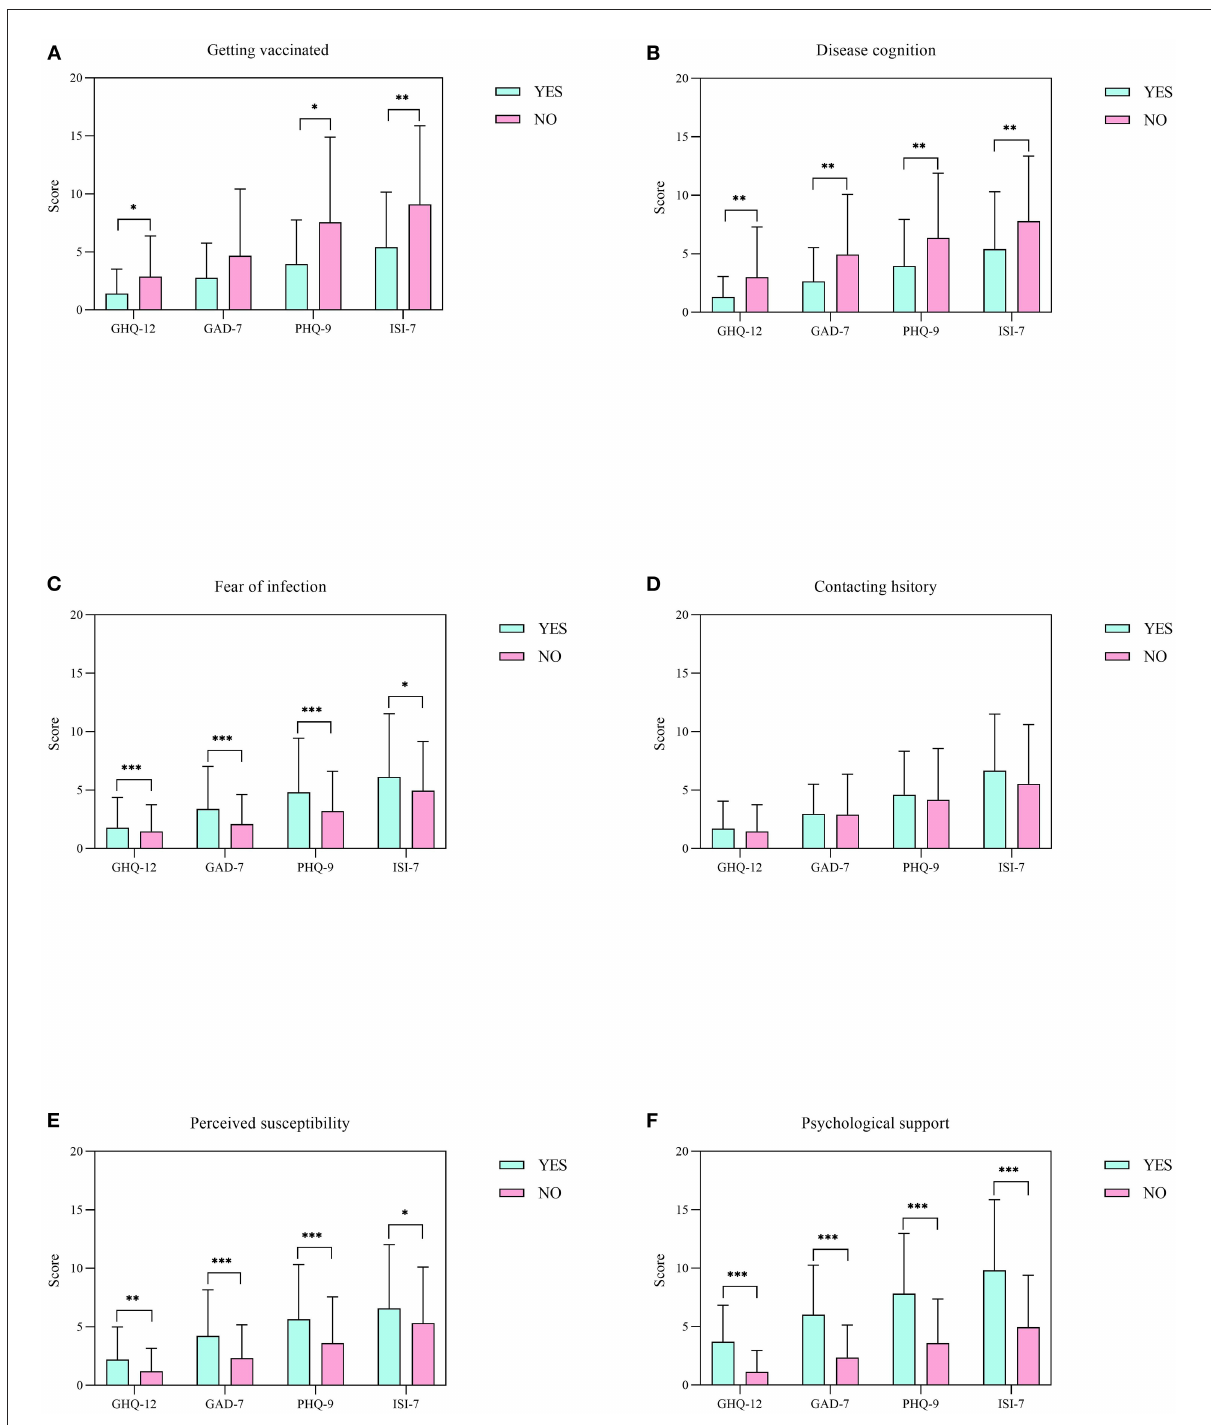
FIGURE2 Comparison of the responses of HCWs for COVID-19-related surveys. (A–F) Scores on the GHQ-12, GAD-7, PHQ-9 and ISI-7 scales for getting vaccinated, disease cognition, fear of infection, contacting history, perceived susceptibility and psychological support among healthcare workers, respectively. All data represent means ± standard deviations (SD). * p < 0.05, ** p < 0.01, and *** p <